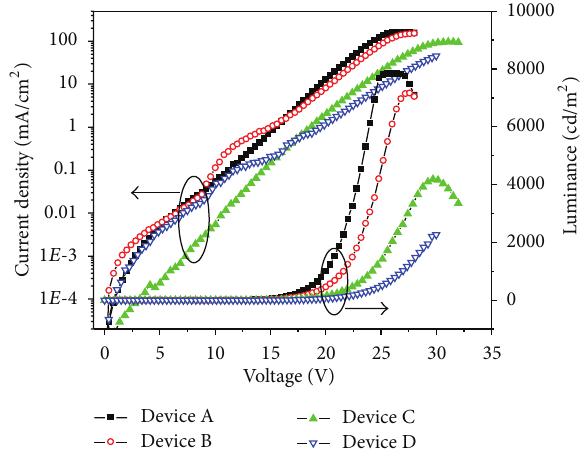
Figure 2: Current density-voltage-luminance characteristics of four doping concentration